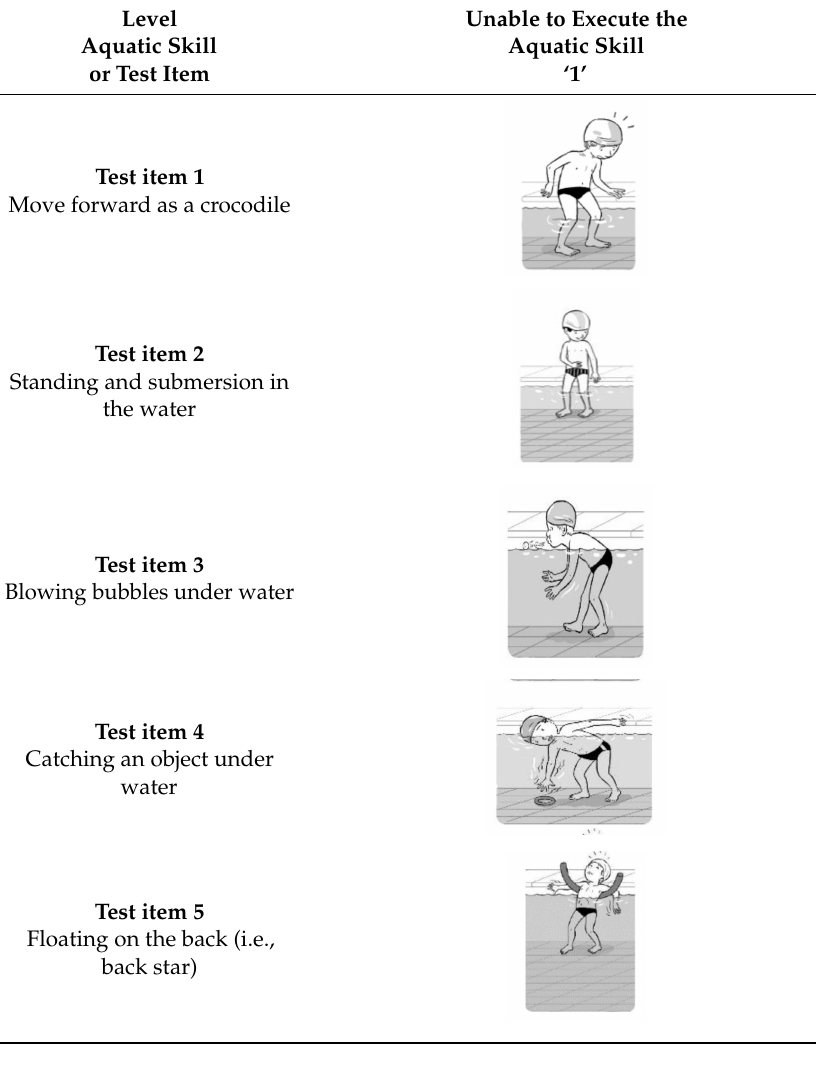
Table 2. Overview of the three different mastery levels per test item as included in the Pictorial Scale of Perceived Water Competence (PSPWC)